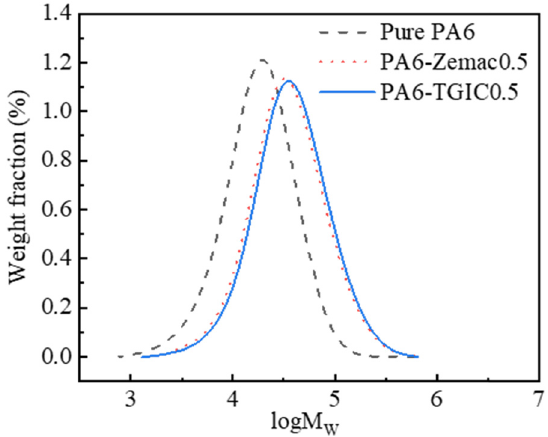
Figure 2: Molecular weight distributions of the pure PA6, PA6 - ZeMac, and PA6 -